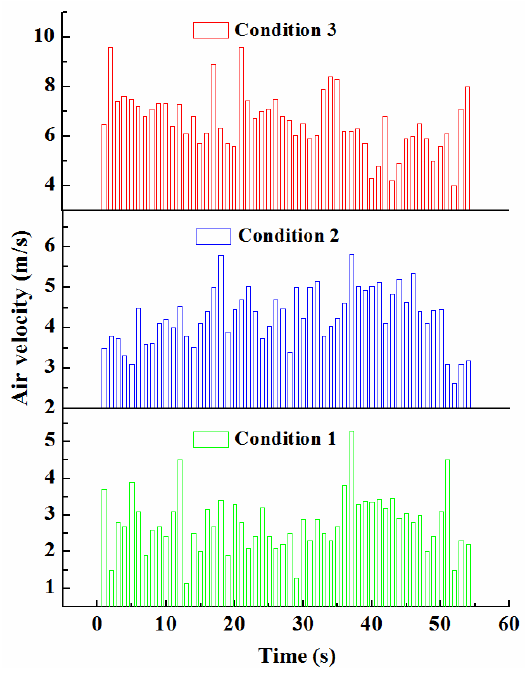
Figure 10. Variation of air velocity under natural